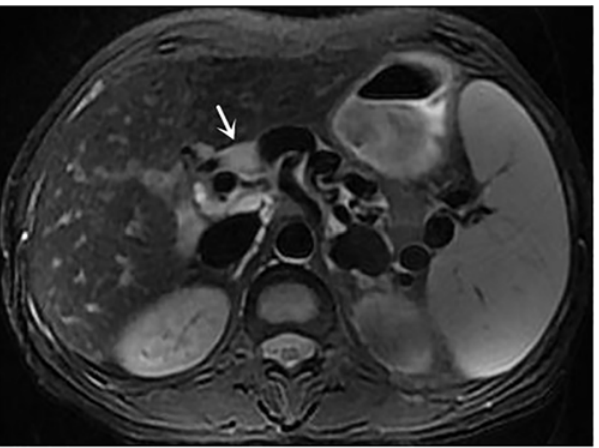
Fig 3. female, 52 years, axial T2-weighted MRI shows lymphadenopathy ( arrow ), and portosystemic collaterals are shown as areas without signal intensity.